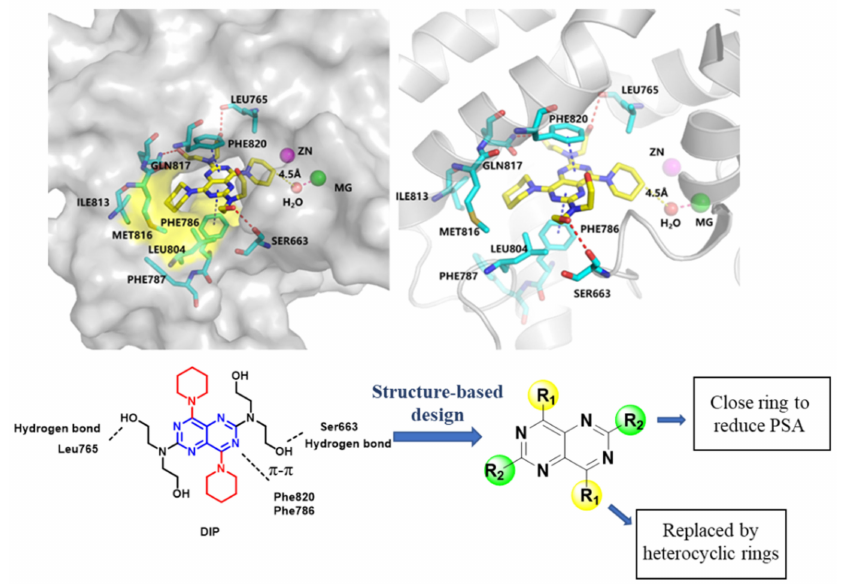
Figure 1. Chemical structure and putative binding pattern of dipyridamole with PDE5, according to the molecular docking and the design strategy for PDE5